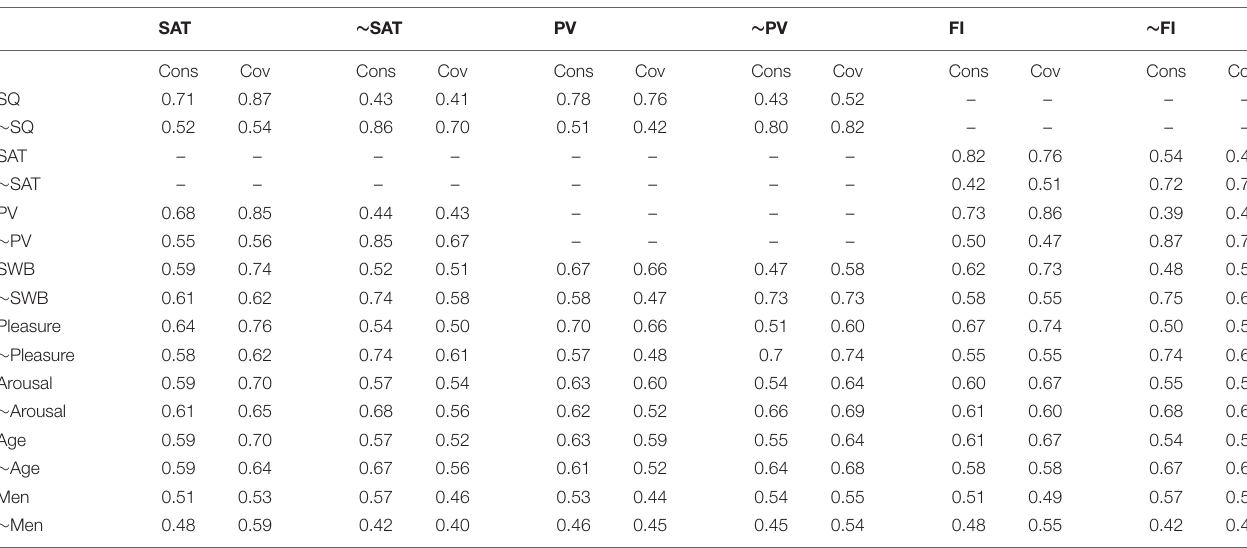
TABLE 3 | Necessity analysis for satisfaction, perceived value, and future